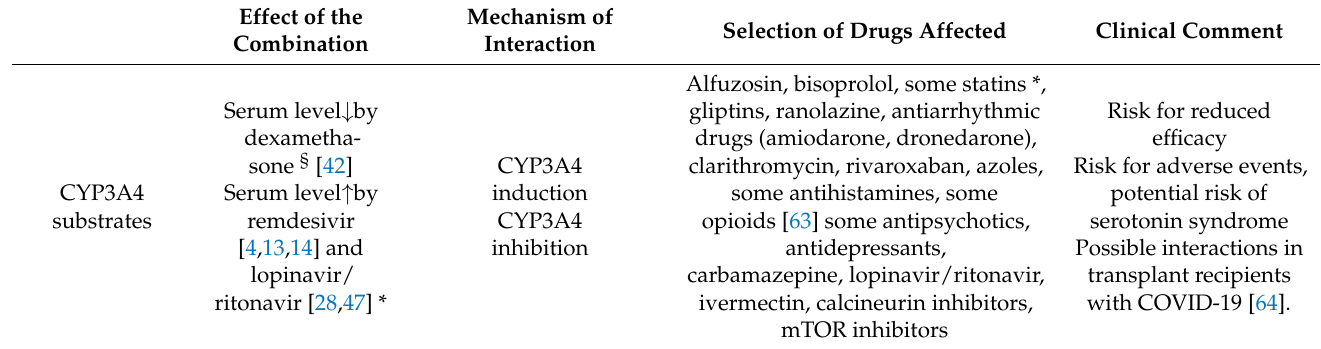
Table 4. COVID-19 drugs as perpetrators of drug-drug